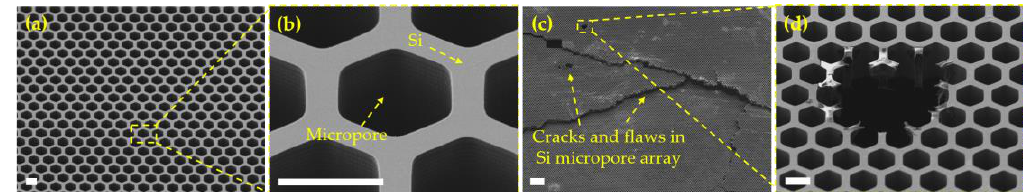
Figure 3. The prepared silicon micropore arrays via micropatterning and etching. ( a ) The well-prepared silicon micropore array; ( b ) the amplification view of the squared area in ( a ); ( c ) defects (cracks and flaws) in silicon micropillar arrays due to the poor mechanical strength; ( d ) the amplification view of the squared area in ( c ). The scale bars are 10 μm ( a , b , d ) and 100 μm in ( c ).